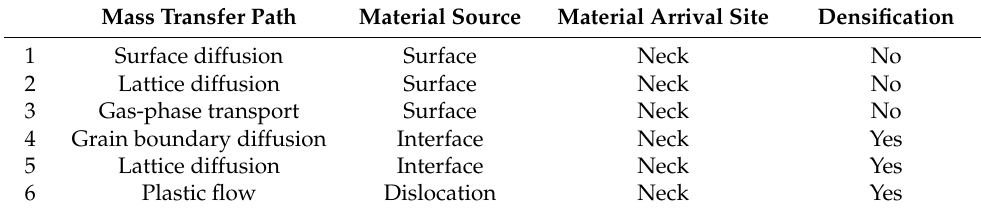
Table 4. The mass transfer mechanism of flash sintering.